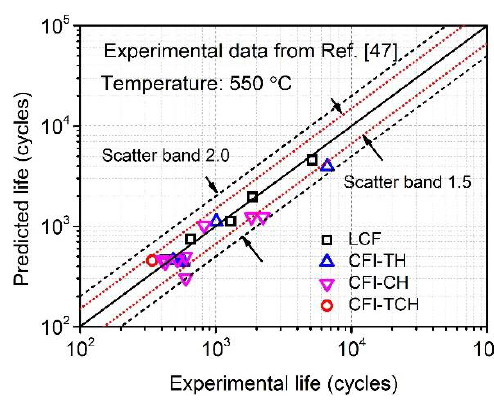
Figure 10. Comparison between experimental life from [47] and predicted life using MMCB model. Table 6. Parameters required for the fatigue life prediction in various models.